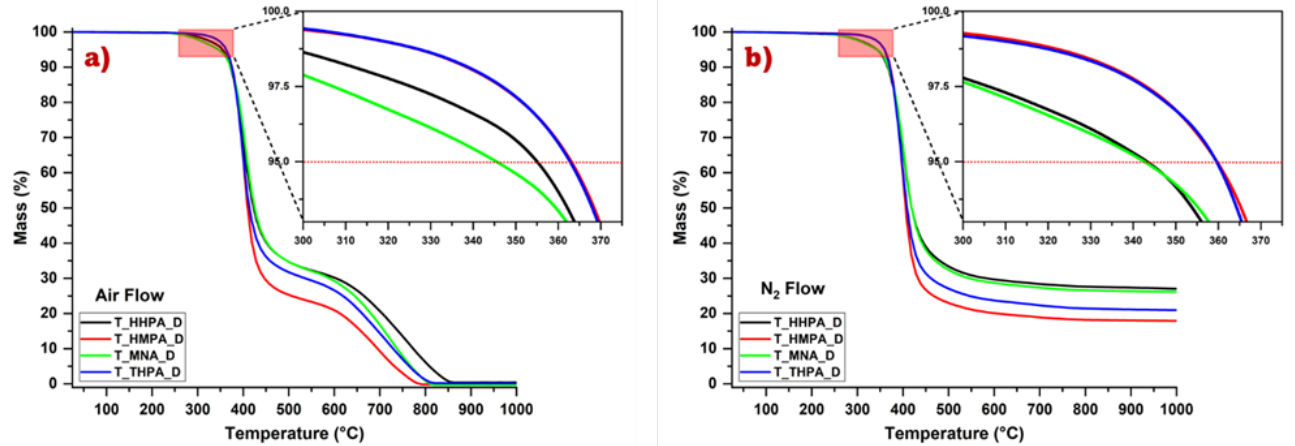
Figure 7. TGA thermograms obtained during heating the thermosets at 10 °C/min under ( a ) air flow, and ( b ) N 2 flow.